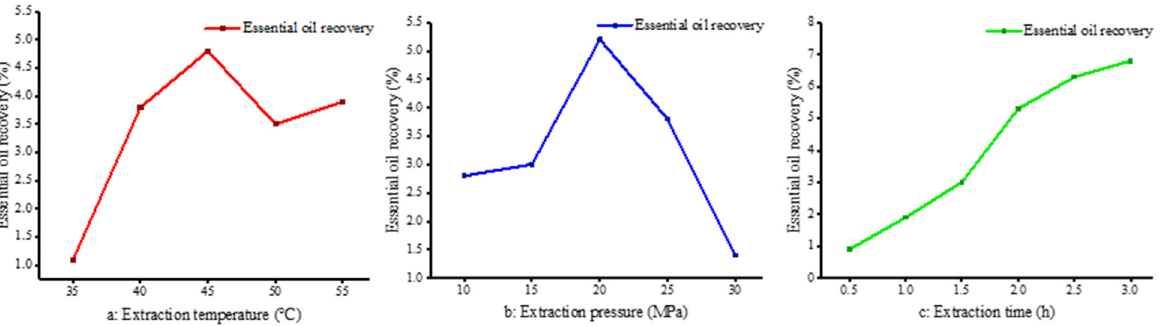
Figure 1. Effect of different conditions on extraction rate. ( a : Extraction temperature, P = 20 MPa, Tm = 2 h; b : Extraction pressure, T = 45 °C, T m = 2 h; c : Extraction time, T = 45 °C, P = 20 MPa).